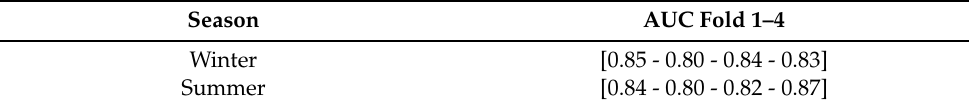
Figure 10. The spatial CV grid is represented. Each color corresponds to a different fold. Table 3. AUC for the four folds of the spatial